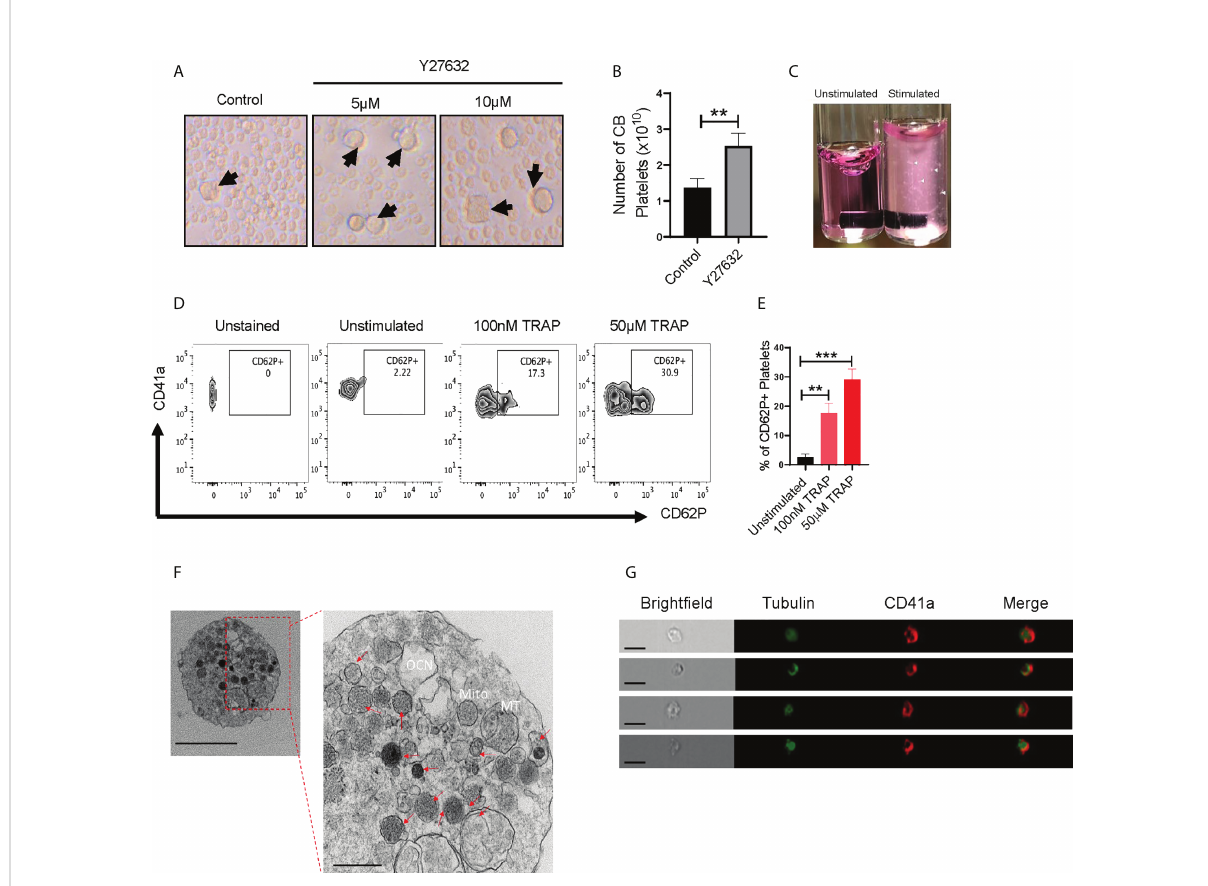
FIGURE 2 CB-MK-derived platelets are functional and exhibit aggregation characteristics. (A) Representative 10X images of differentiating MKs under normal conditions and with 5-10 m M Y27632, with examples of larger MKs marked by black arrows. (B) Number of secreted platelets from MKs treated with shear stress for 6h and were untreated or pretreated with 10 m M Y27632 for 96h (n=3, **p<0.01). (C) Representative image of unstimulated and 5 m g/ml collagen stimulated platelets in tubes. White triangles indicate aggregating platelets. (D) Flow cytometry contour plots depicting CD62P (P-selectin) expression in unstimulated and TRAP-stimulated platelets. (E) Frequency of CD62P+ platelets after TRAP stimulation or without stimulation (n=3, **p<0.01 and ***p<0.001). (F) Transmission electron microscopy (TEM) 10000X (left, scale bar = 2µm) and 50000X (right, scale bar = 500nm) resolution images of a CB-MK-derived platelet (Abbreviations: Mito, mitochondria; MT, microtubule; OCN, open canalicular network; red arrows, granules). (G) Imaging fl ow cytometry of platelets generated from CB-MKs and assessed for the expression of tubulin and CD41a (scale bar = 7 µm). All statistical analyses completed with unpaired